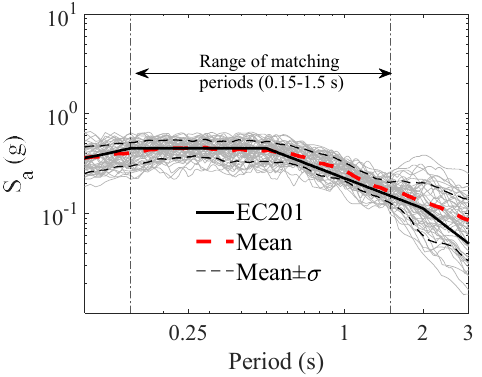
Figure 9. Scaled response spectra for the fifty ground motions with their mean response spectrum and the target elastic response spectrum for Zone 3 of the Egyptian territory according to the Egyptian code for loads EC201 (Type 2 design response spectrum and Soil B).